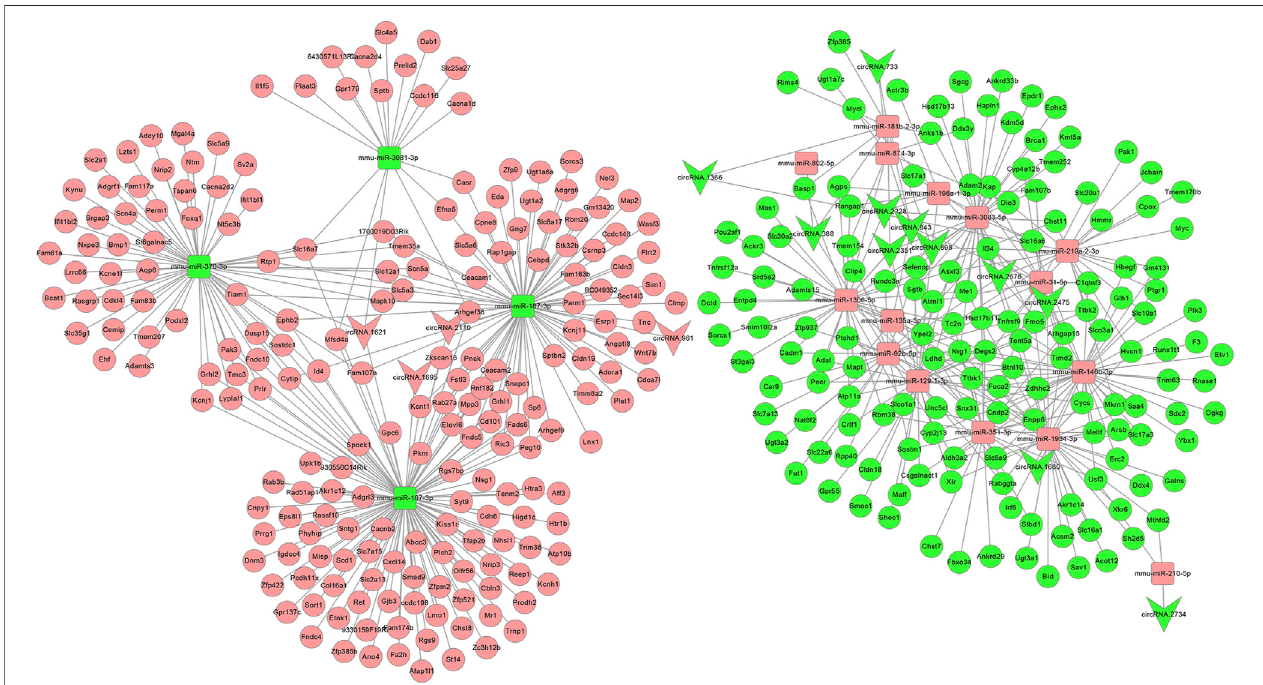
FIGURE 6 | The circRNA ceRNA network. V-shaped, square, and circle nodes represent circRNA, miRNA, and mRNA, respectively. Red and green represent upregulation and downregulation,